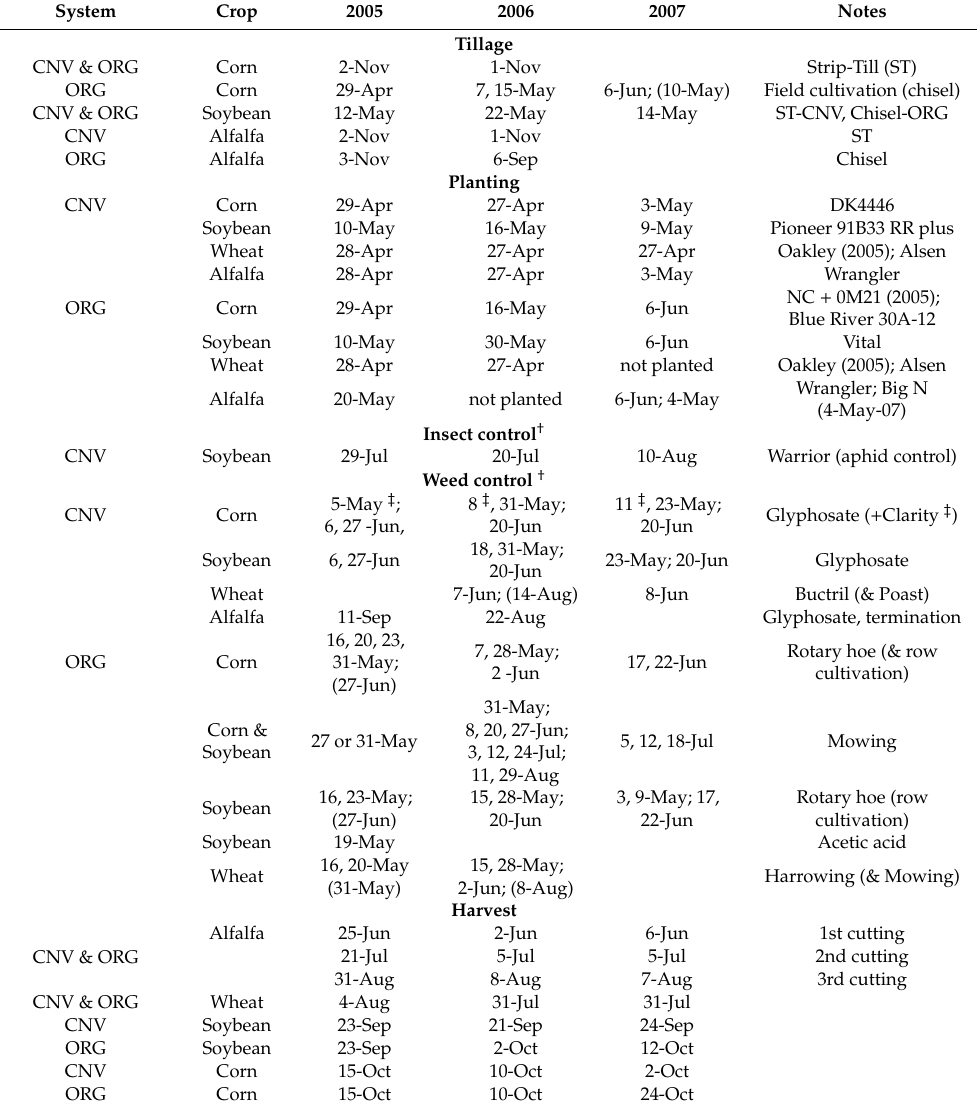
Table 1. Dates for tillage, planting, pest and weed control, and harvest by conventional (CNV) and organic (ORG) management system and